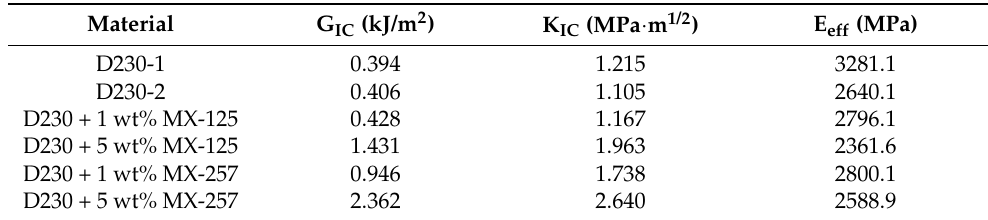
Table 3. Fracture properties of epoxy resins determined from experimental SENB tests. The G IC and K IC values are used to calculate E eff according to Equation